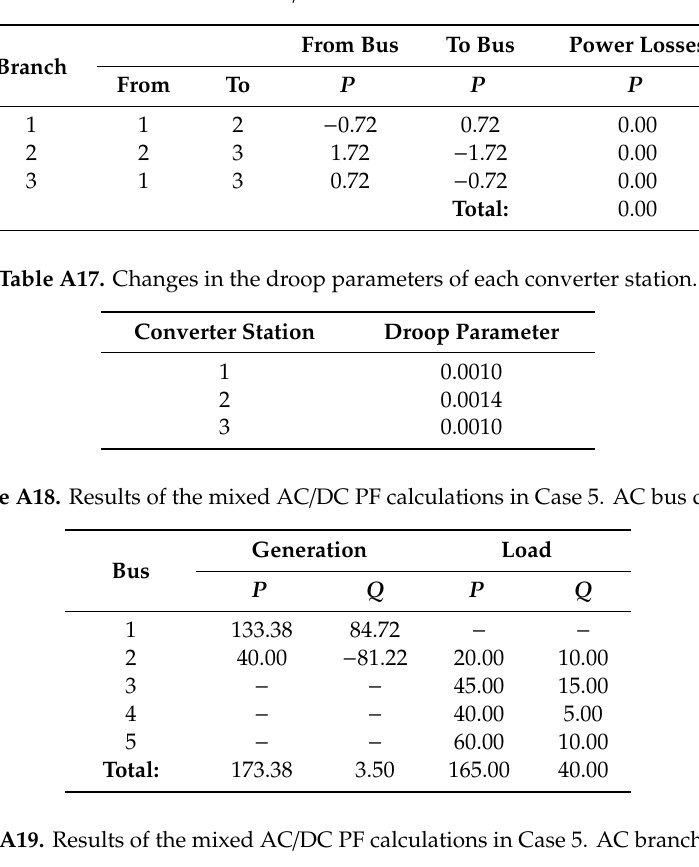
Table A16. Results of the mixed AC / DC PF calculations in Case 4. DC branch data.